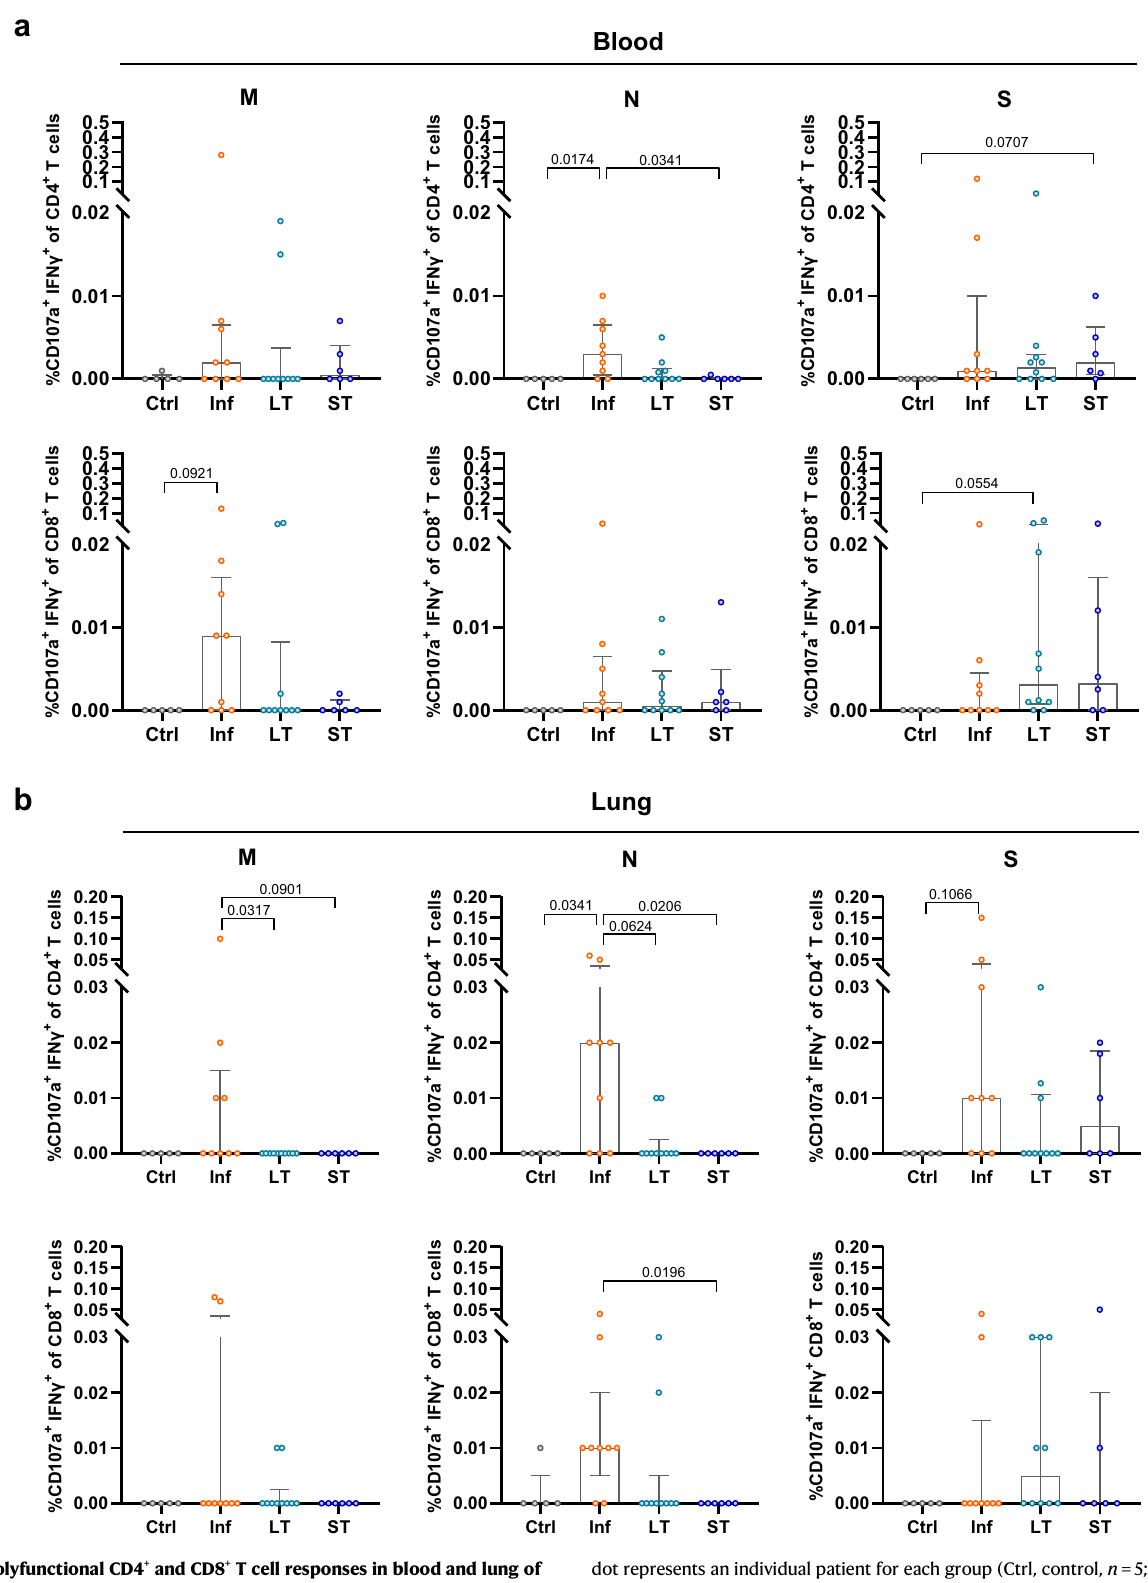
dot represents an individual patient for each group (Ctrl, control, n =5; Inf, con- valescent infected, n =9; LT, vaccine 2/3 doses, n =10, and ST, vaccine 3/4 doses, n =6). Statistical signi fi cance was determined by was determined using Kruskal – Wallistest(withDunn´spost-test,two-sided).Sourcedataareprovidedas a Source Data fi